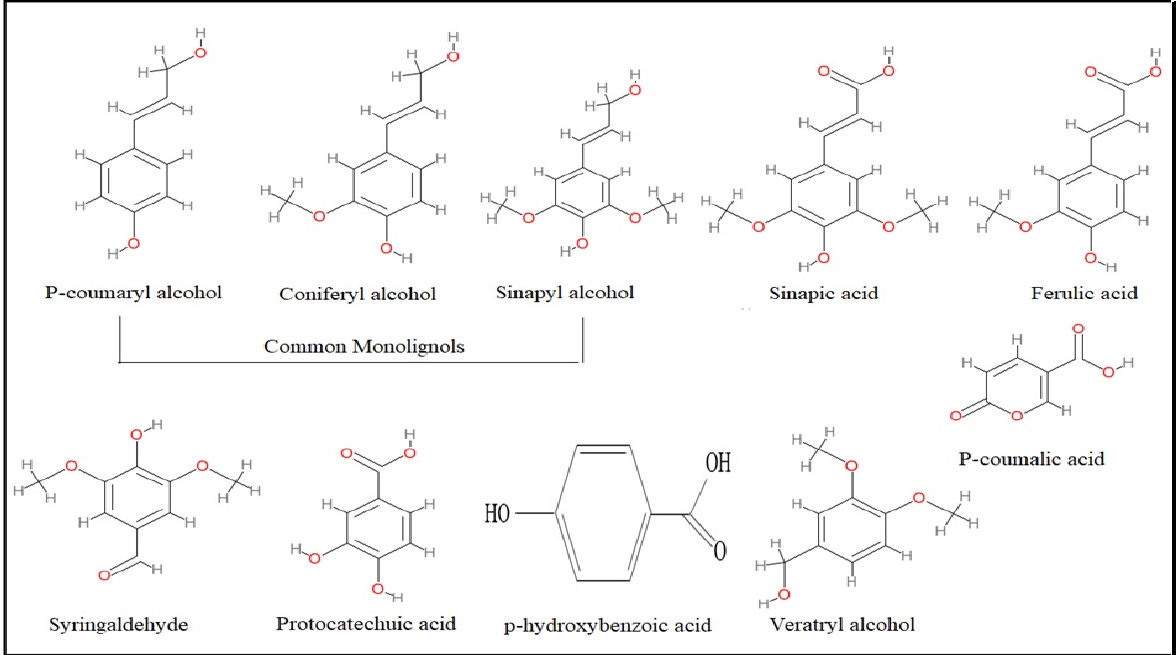
Figure 2. Different types of lignin derived compounds.